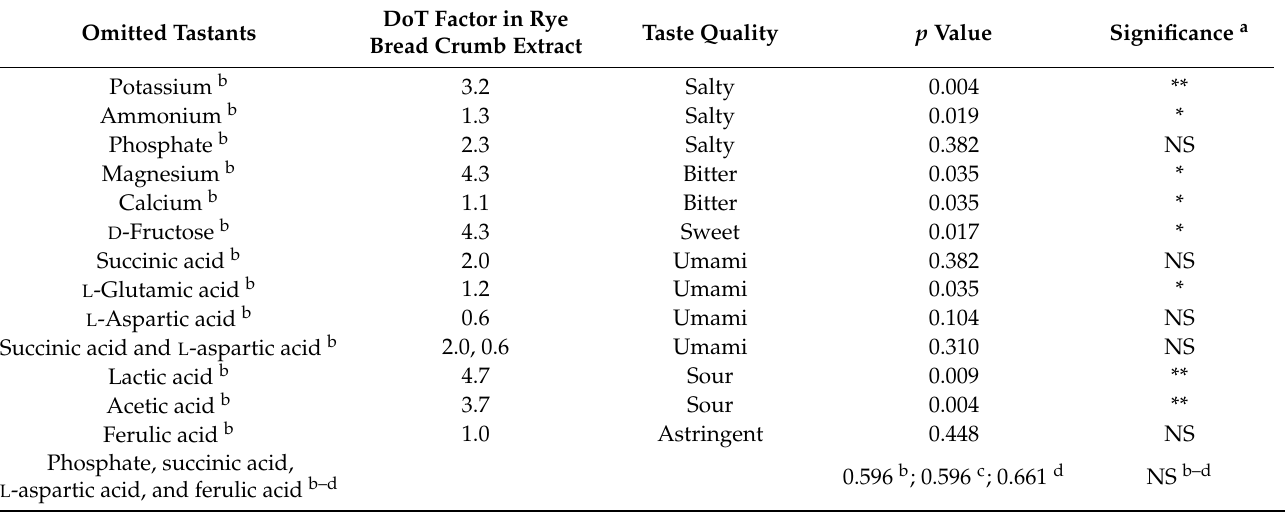
Table 3. Omission experiments performed with the taste recombinant of rye bread crumb using triangle